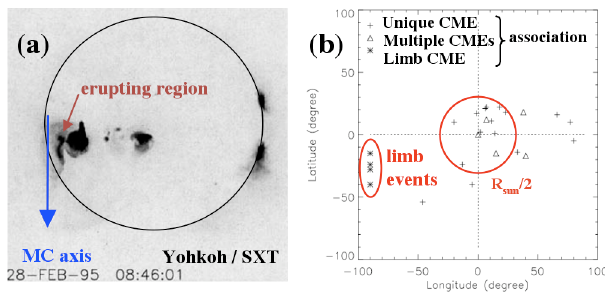
Fig. 2. Examples of MCs/ICMEs reaching the Earth while their source regions are located far from the solar disk center. (a) Erup- tion observed in X-rays (Watari et al., 2001). (b) Distribution of the source regions of CMEs causing major geomagnetic storms (Zhang et al., 2003). There is a global western asymmetry shift (compa- rable to the source location of the solar wind at Earth due to the Parker spiral). Still, four cases are coming from behind the eastern limb (thus with no visible solar source).